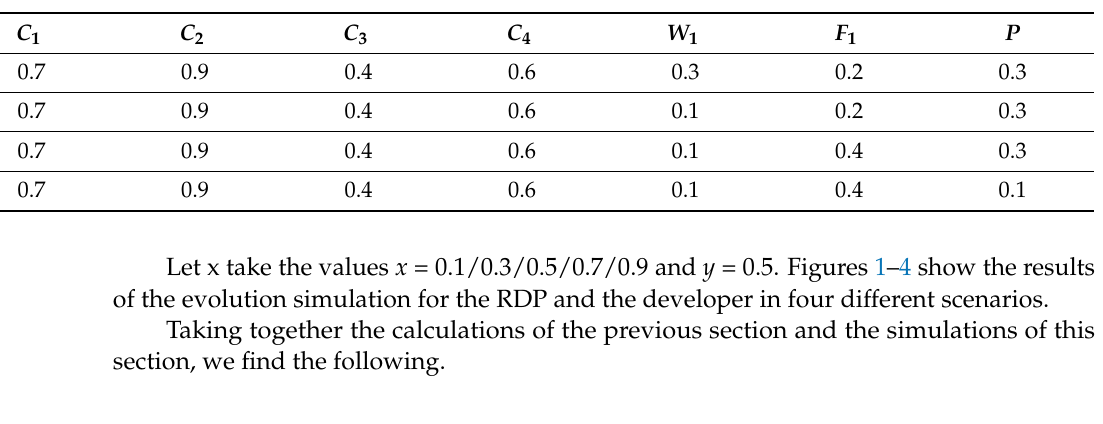
Table 6. Parameter assignment for MATLAB simulation of RDP vs. hydropower